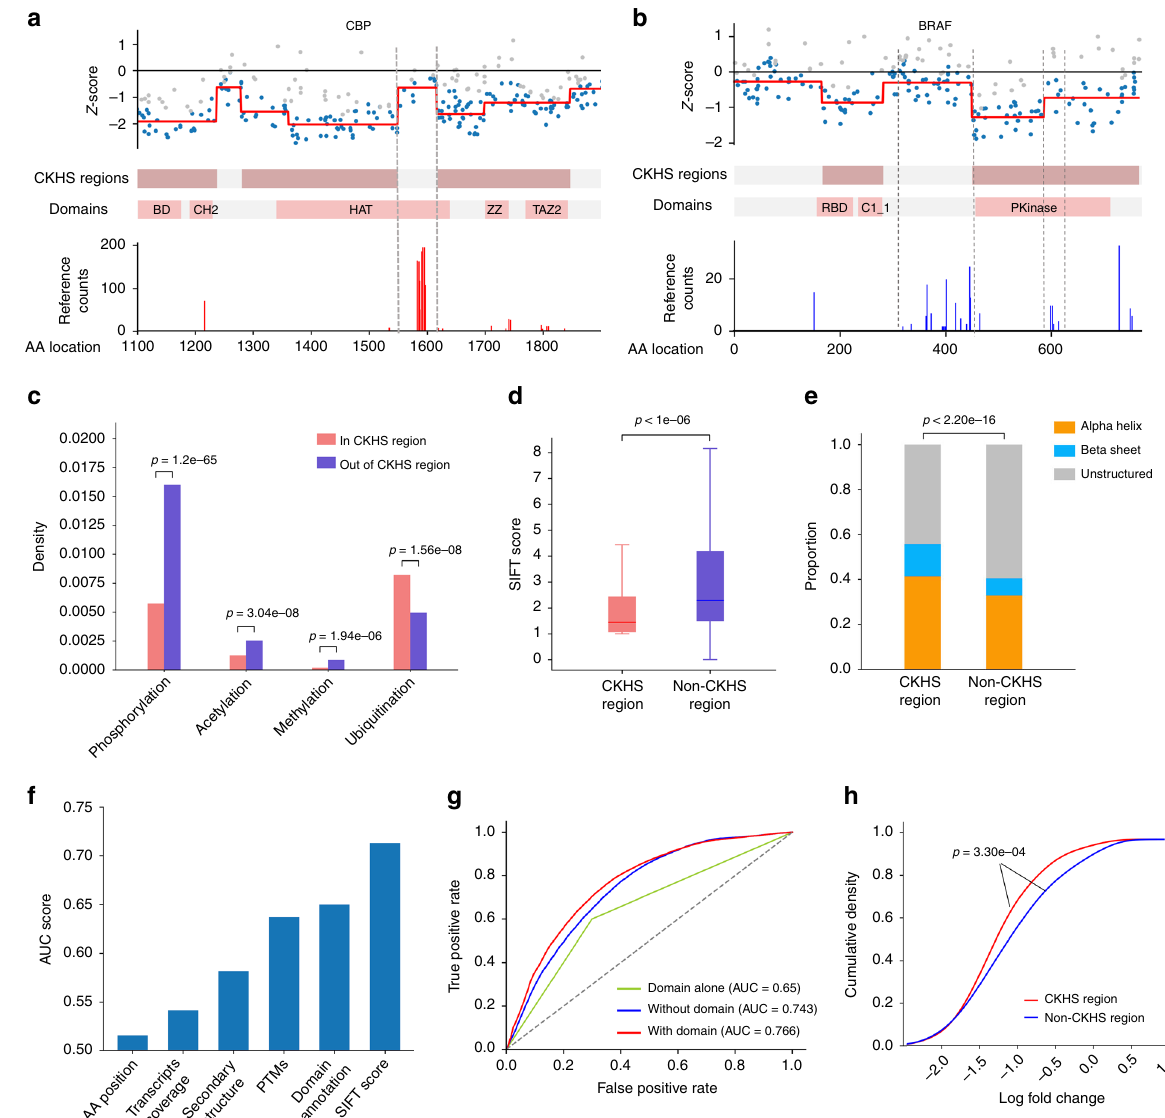
Fig. 4 CKHS regions are are predictable from protein features. a The zoomed-in views of CKHS pro fi le, domain annotation, and acetylation sites of CBP (AA1100-1900). The Y -axis of the PTM pro fi les represents the number of publication references collected at https://www.phosphosite.org. b The CKHS pro fi le, domain annotation, and phosphorylation sites of BRAF. c A bar chart showing the density of PTM sites inside or outside of the CKHS regions. The p - values were computed based on hypergeometric distribution. d A box-plot showing the association between CKHS regions and amino acids conservation (SIFT score). The center line, bounds of box and whiskers represent the median, interquartile range and 1.5 times interquartile range, respectively. The p - value was computed using the Mann – Whitney test. e A bar chart showing the distribution of secondary structures for CKHS and non-CKHS regions. The p - value was computed using the Chi-square test. f A bar chart showing the predictive power of bagging SVM, in ROC-AUC score, using individual protein features. The AA position in the protein and the transcript coverage are used as references. g ROC curves showing the predictive powers using all protein features, all features other than domain annotation, and domain annotation alone, respectively. h The sgRNAs targeting core essential genes were categorized based on predicted CKHS regions. The cumulative distributions of sgRNA dropout effects in Avana dataset 37 are shown for each category. The p -value was computed using Kolmogrov – Smirnov